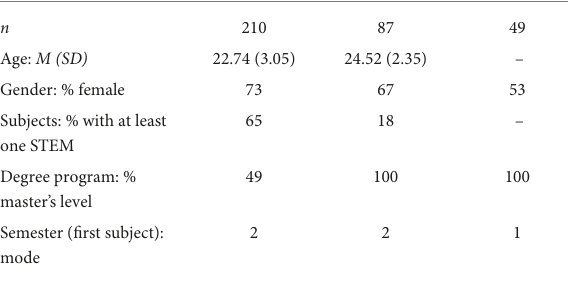
TABLE 1 Overview of the three